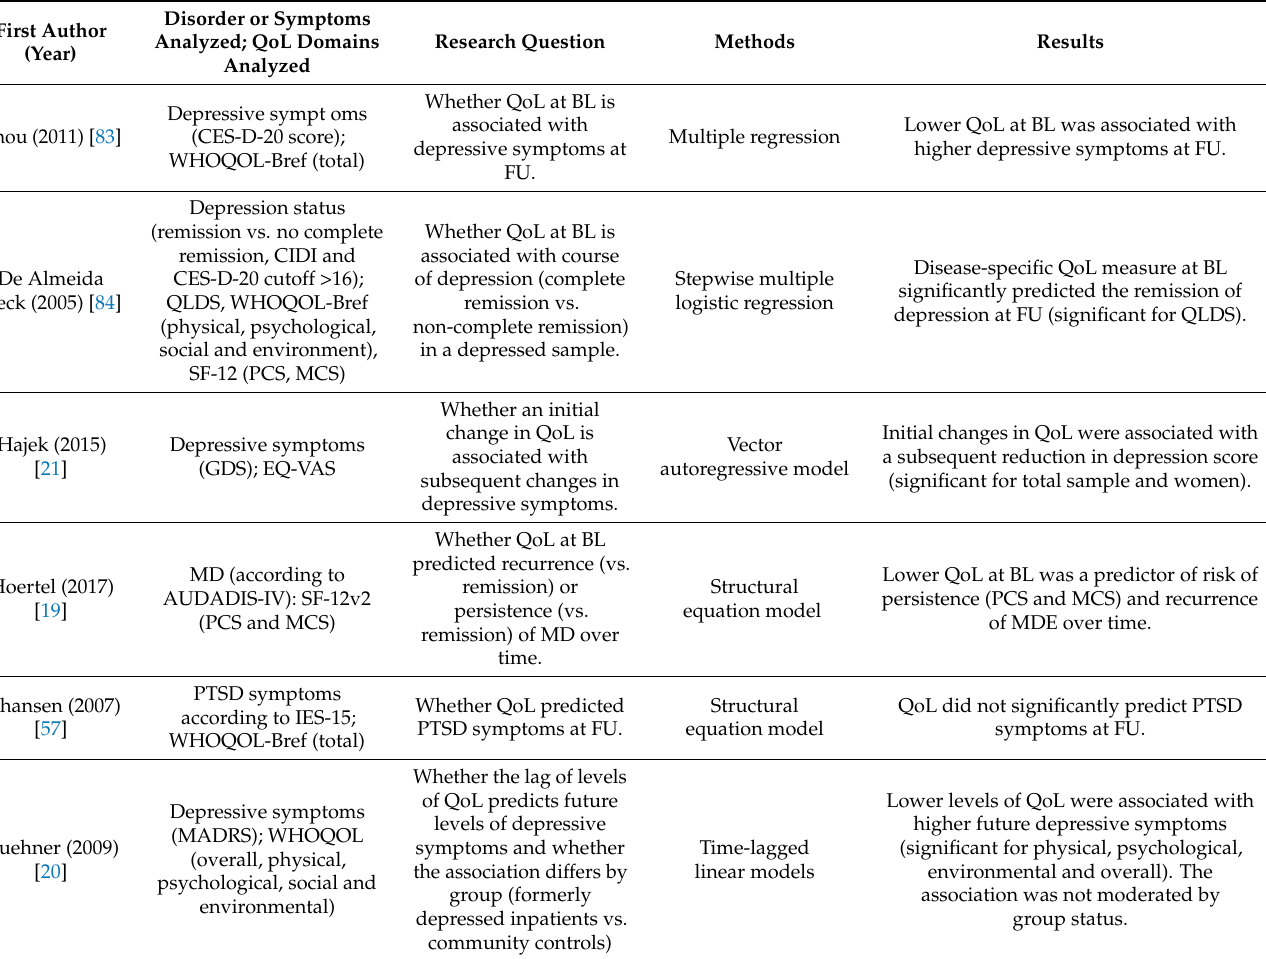
Table 3. Studies on depression/anxiety as independent variables and QoL